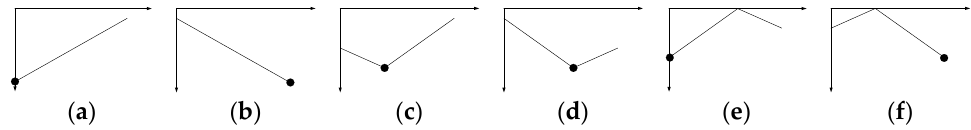
Figure A5. dist ( o , p ) × CI( Q , p ) graphs for Case 4: ( a ) case 4.1, ( b ) case 4.2, ( c ) case 4.3, ( d ) case 4.4, ( e ) case 4.7, and ( f ) case 4.8.